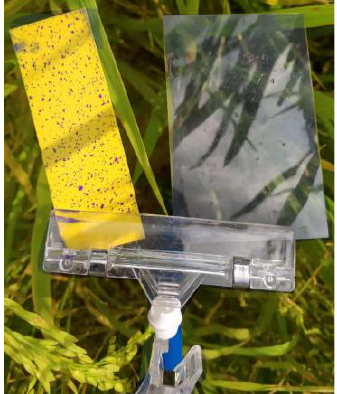
Figure 16. Inner sampling bands of adjacent operation units. Note: S1, S2, S3, S4, S5, S6, S7, S8, S9, S10, S11, S12, and S13 are the numbers of the collection bands.